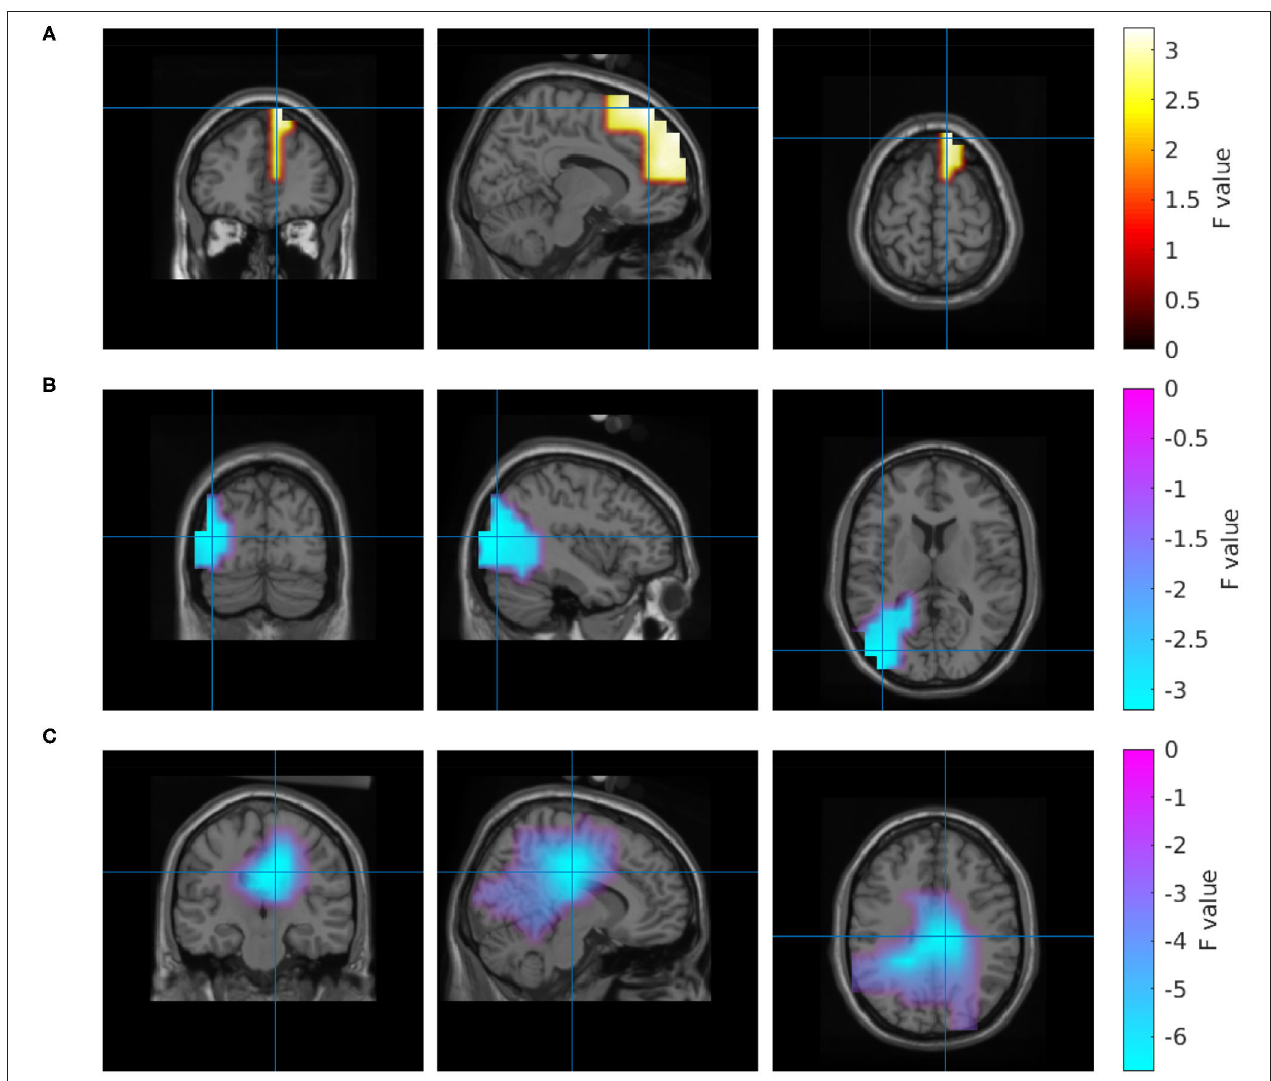
FIGURE 4 | Source reconstruction of the power differences between the collaborative and the individual condition in the frequency range 66–120 Hz (A,B) and 1–30 Hz (C)